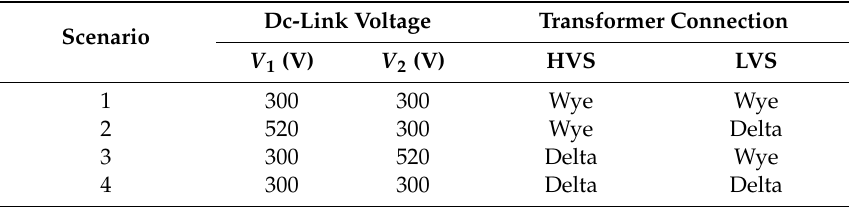
Table 2. DC-link voltages at bridge 1 and bridge 2.